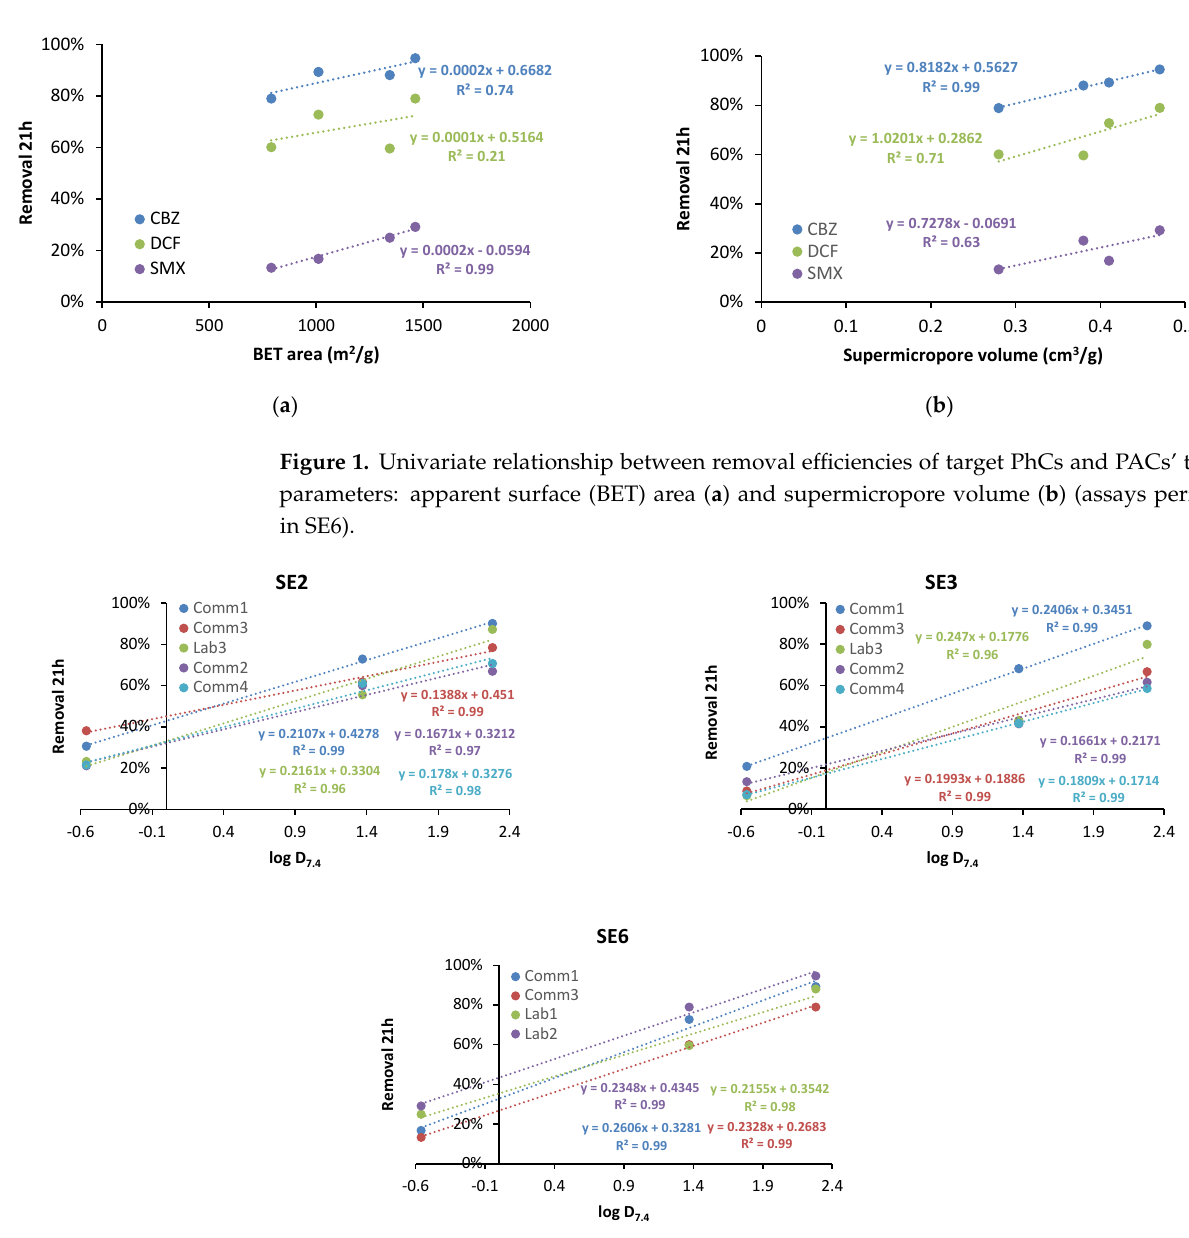
Figure 2. Univariate relationship between removal efficiencies of target PhCs and log D 7.4 values of CBZ, DCF, and SMX for assays performed in distinct WWTP